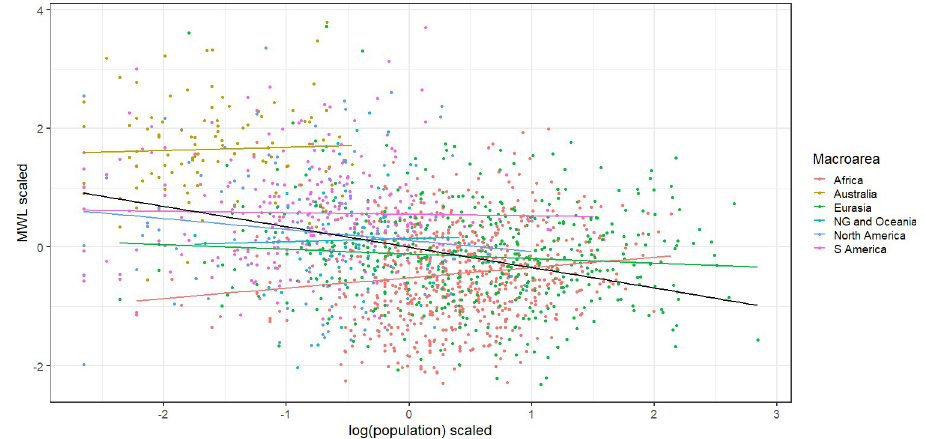
Fig 3. Scaled mean word length as a function of scaled log population, for 1706 languages in six macroareas. Regression lines fitted within each area are color-coded like the languages; the regression line for all 1706 languages is